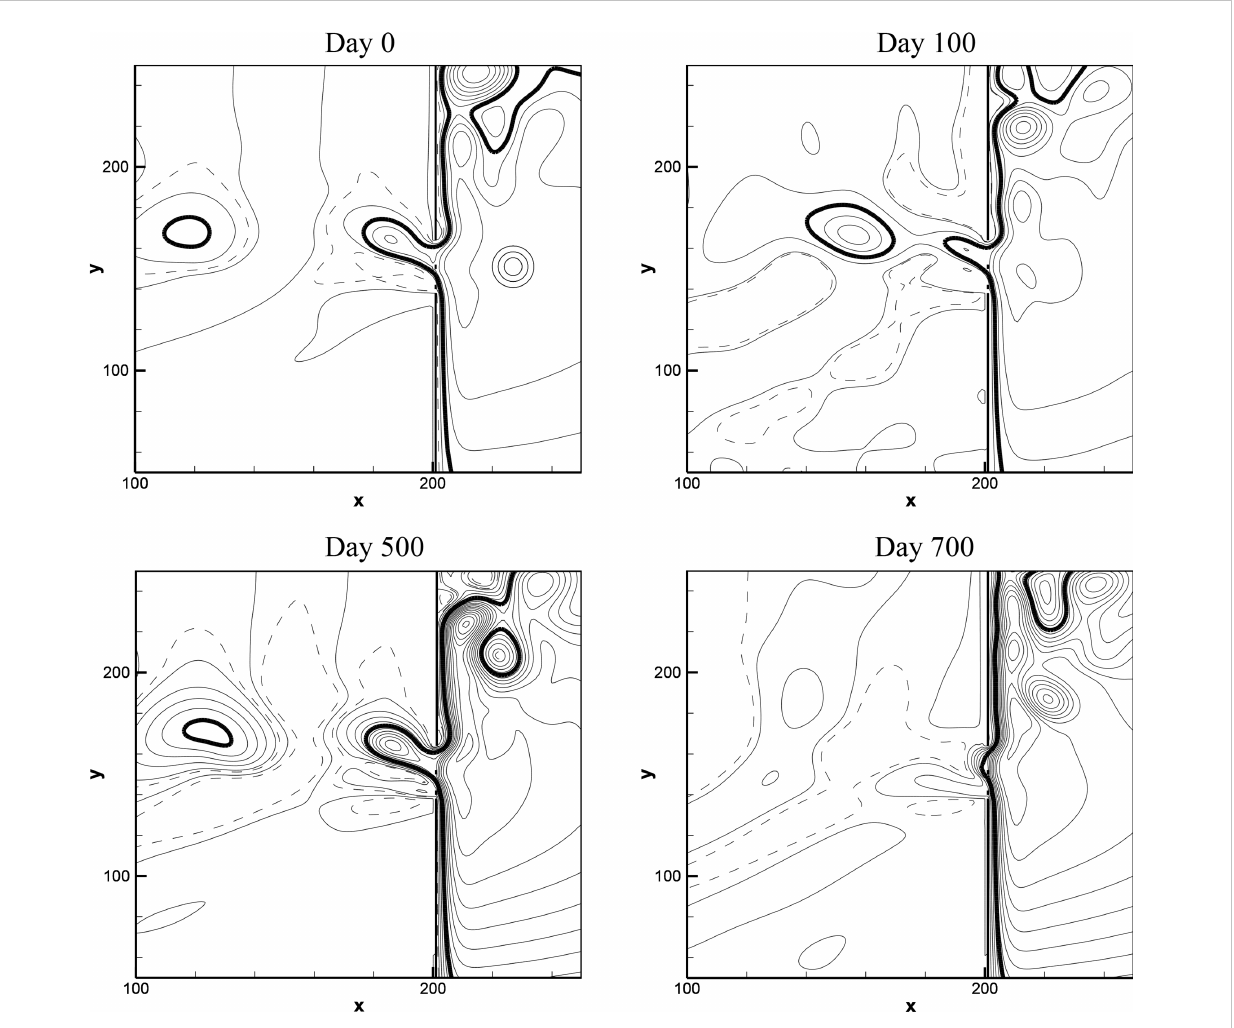
FIGURE 4 Time evolution of the WBC critical from the eddy-shedding to leaping regime at Re = 76 impinged by an anticyclonic eddy in the vicinity of the gap with two islands. An initial anticyclonic eddy with a radius of approximately 80 km is inserted 300 km east of the gap into the background fl ow, and it propagates toward the gap. The critical strength of the eddy ( y c = 26,000 m 2 s − 1 ) is the minimum value that can induce the critical WBC transition from penetration to leap. WBC, western boundary